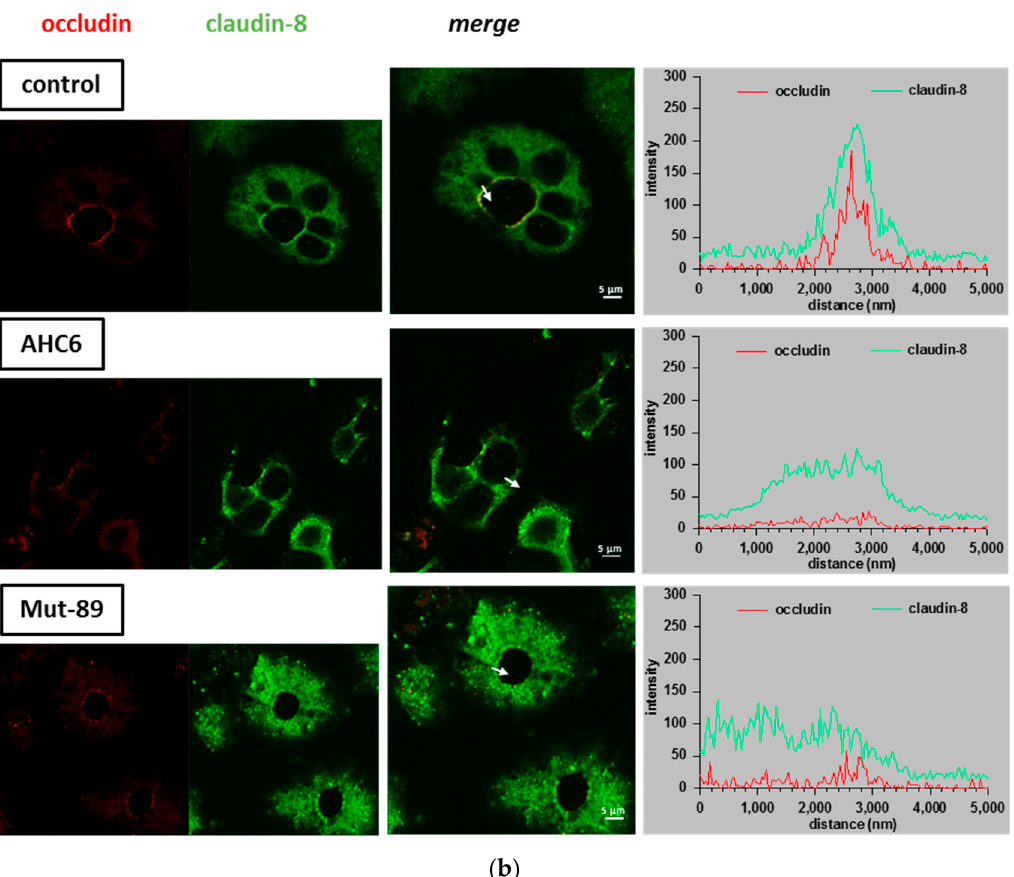
Figure 4. Immunofluorescence staining of claudins in colon crypts from an AAHC ( antibiotic-associated hemorrhagic colitis) mouse model. Representative micrographs show immunostaining of occludin (red) and ( a ) claudin-5 or ( b ) claudin-8 (green) in mouse colon crypts of control, AHC6-infected, and Mut-89-infected mice ( n = 4 each group; claudin-5 and -8). Signal intensity and localization of representative areas are shown in intensity–distance plots. Arrows were located using Zeiss Zen software and mark the range and direction of the intensity–distance plot.